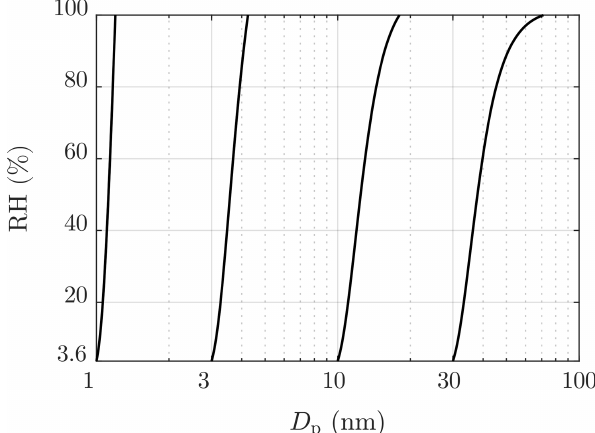
Figure 8. Examples of particle diameters in different humidities in the temperature of 23 ◦ C. The lowest RH value represents the RH of the dilution air of the ejector